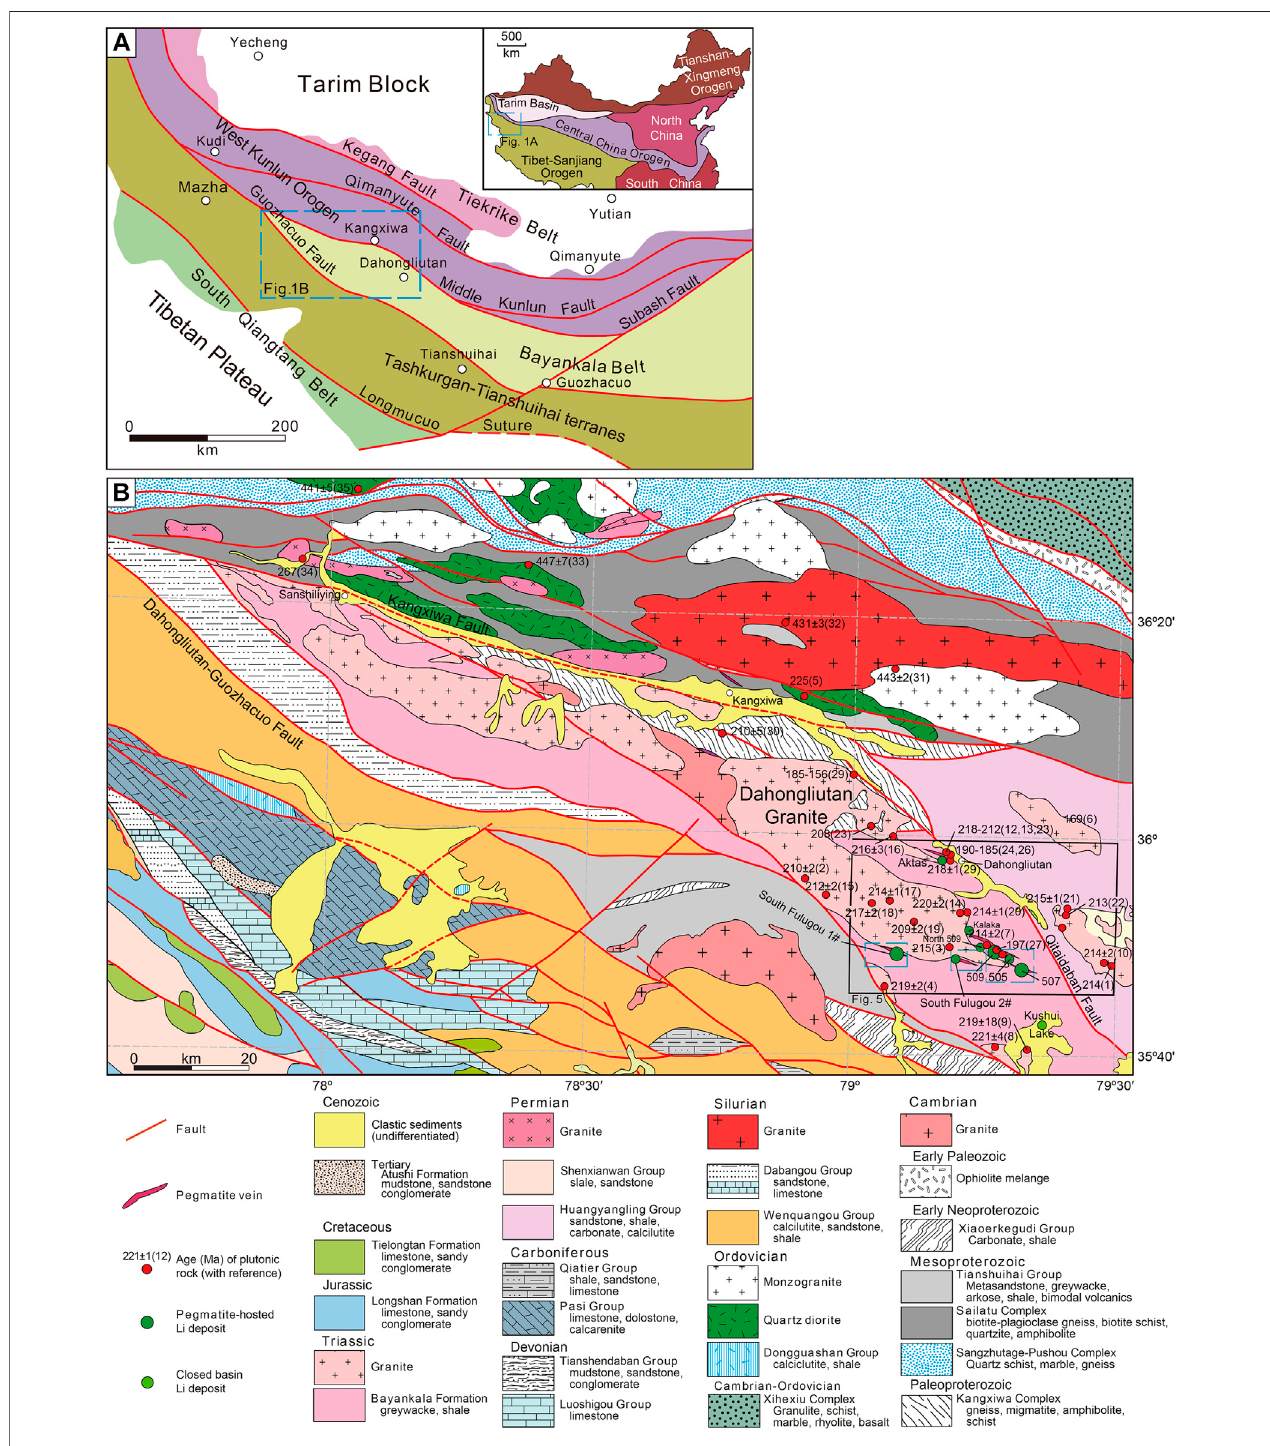
FIGURE1| ThegeologicalmapintheDahongliutanarea,NWChina: (A) TectonicunitsoftheWestKunlunOrogenandBayankalaFoldBelt(modi fi edafterXiaoand Gao 2015); and (B) the geological map and distribution of the spodumene-bearing pegmatites in the Dahongliutan area (from data collected during this study).